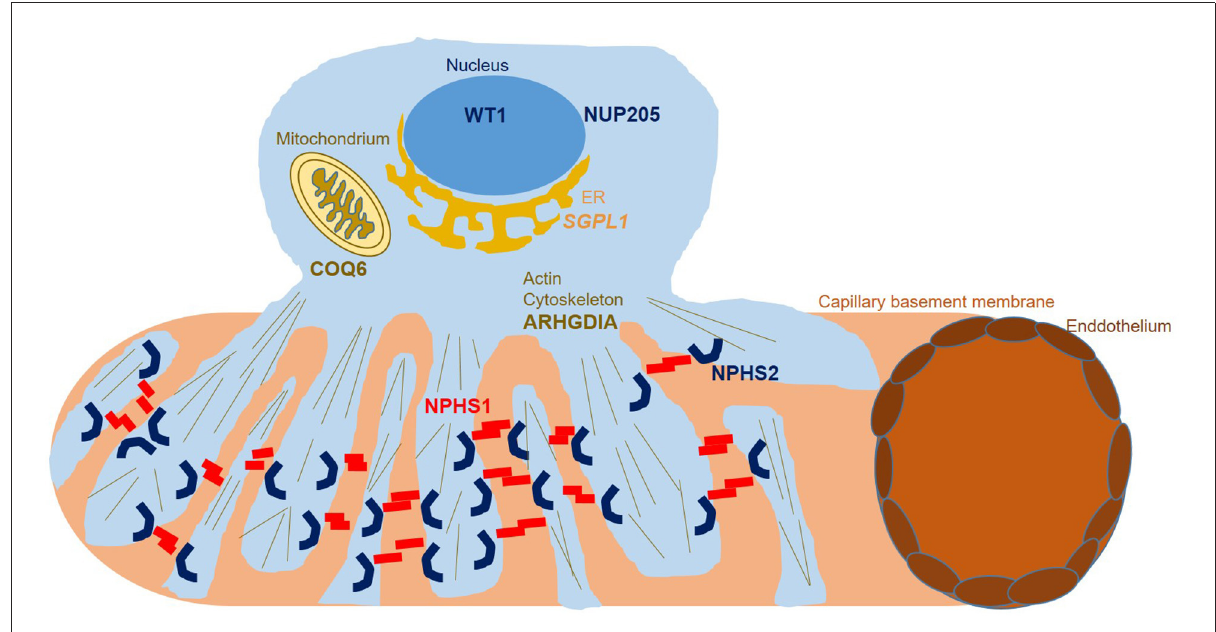
FIGURE3 Podocyte subcellular localization of proteins encoded for by genes found to carry disease alleles in this study. While WT1 functions as a transcription factor in the nucleus, NUP205 functions within the nuclear pore complex, enabling transport between the nucleus and the cytoplasm. SGPL1 represents an endoplasmic reticulum based enzyme catalyzing sphingolipid breakdown resulting in cleavage of the lipid-signaling molecule sphingosine-1-phosphate. COQ6 represents a flavin-dependent monooxygenase essential for biosynthesis of coenzyme Q10 which serves as a redox carrier in the mitochondrial respiratory chain as well as an antioxidant protecting cells from reactive oxygen damage. ARHGDIA sequesters Rho-GTPases in an inactive state in the cytosol, controlling RhoA, Rac1, and Cdc42 levels and influencing actin dynamics. NPHS1 and NPHS2 localize to the podocyte foot process membrane, enabling proper function of the glomerular slit diaphragm.